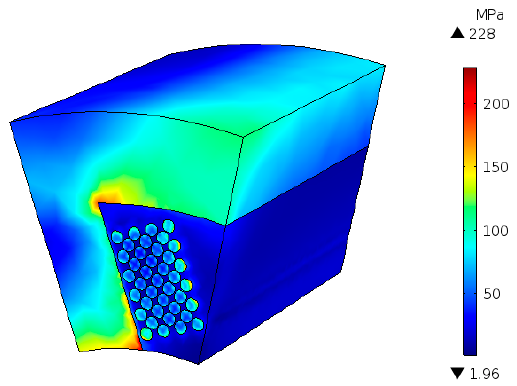
Figure 3. The von-Mises stress distribution over the entire volume. Higher stress is seen near iron- interface, especially in the corner and tooth epoxy interface, especially in the corner and tooth tip.